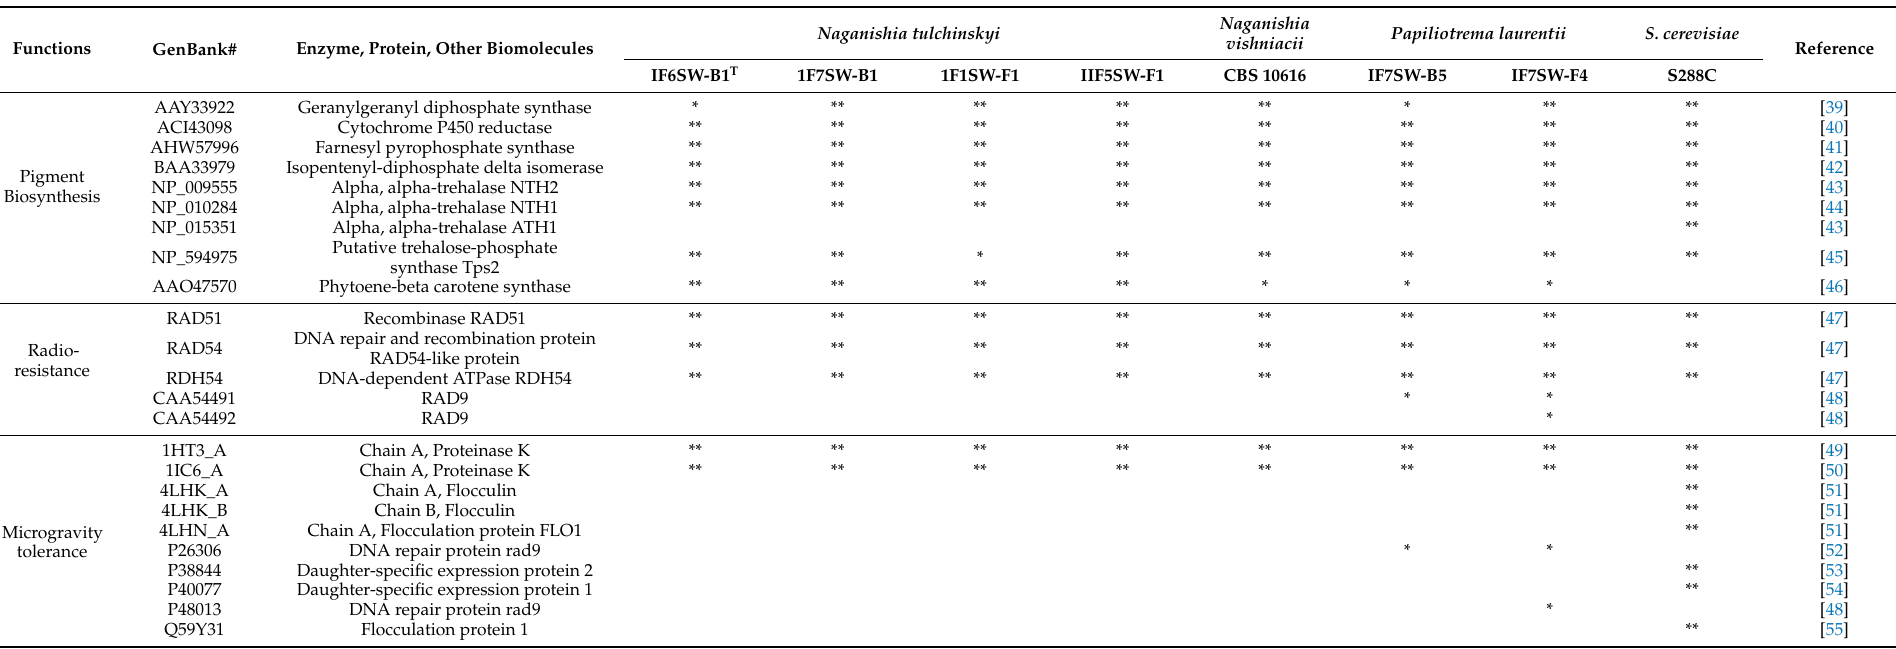
Table 1. Presence of various biomolecules responsible for pigment biosynthesis, radio-resistance, and microgravity tolerance in Naganishia species and S. cerevisiae . Functions